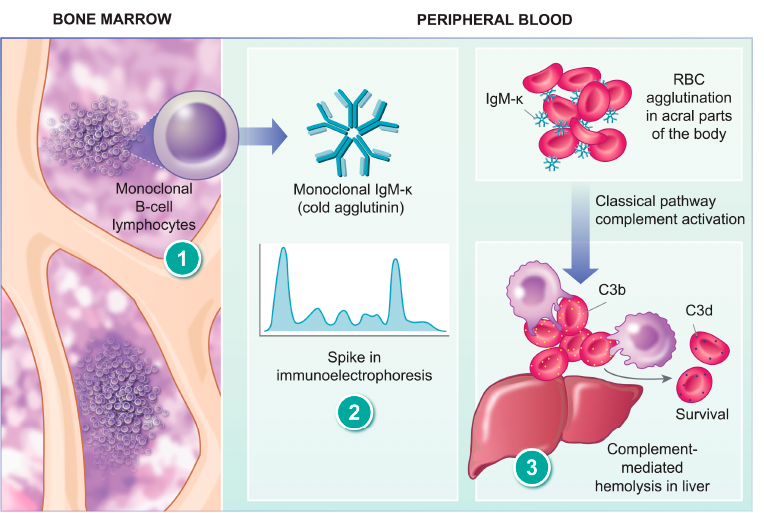
Figure 1. Cold agglutinin disease (CAD) is a form of acquired autoimmune hemolytic anemia (AIHA) caused by a bone marrow lymphoproliferative disorder (1). The clonal B ‐ cell lymphocytes produce monoclonal immunoglobulin (Ig), usually IgM ‐ kappa (2). IgM ‐κ acts as a cold autoanti ‐ body that recognizes its own red blood cells (RBC) producing RBC agglutination at low tempera ‐